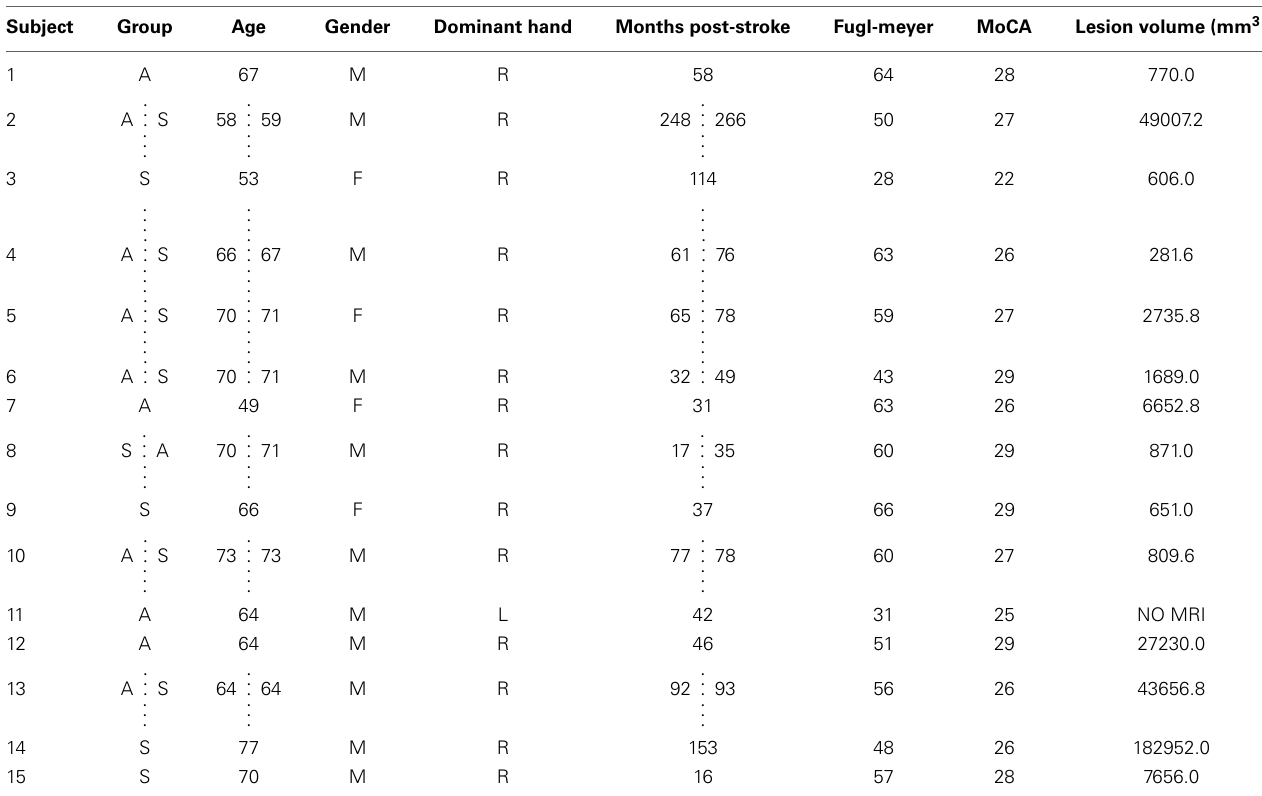
Table 1 | Participant demographics and lesion